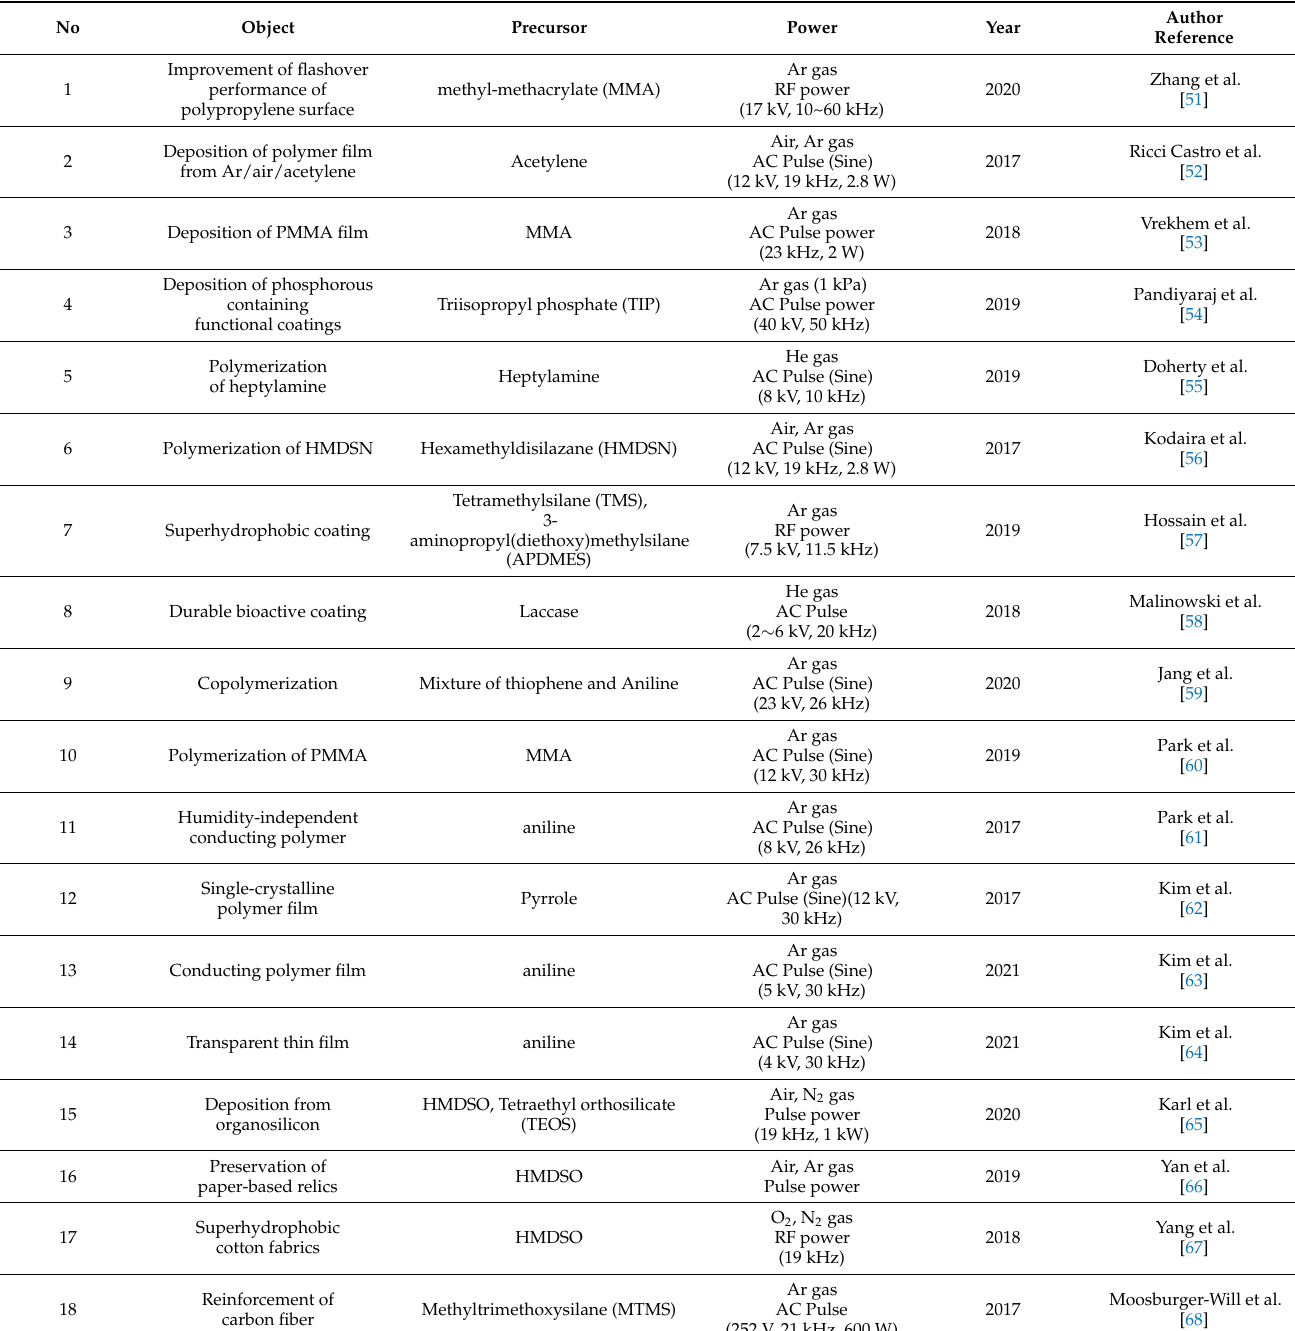
Table 1. Summary of the synthesis of polymers using APPJ